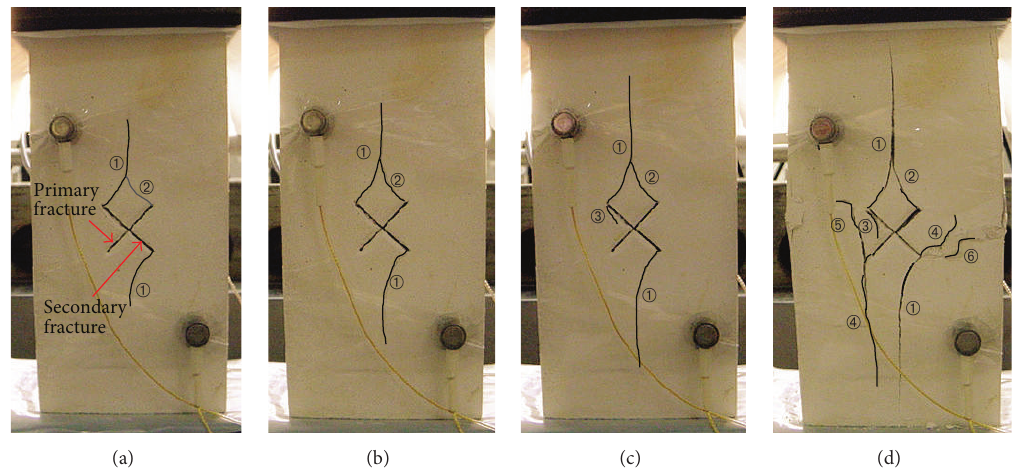
Figure 6: Fracture propagation process of specimen B. (a) 𝜎 1 = 2.41 MPa. (b) 𝜎 1 = 3.11MPa. (c) 𝜎 1 = 3.91 MPa. (d) Failure.